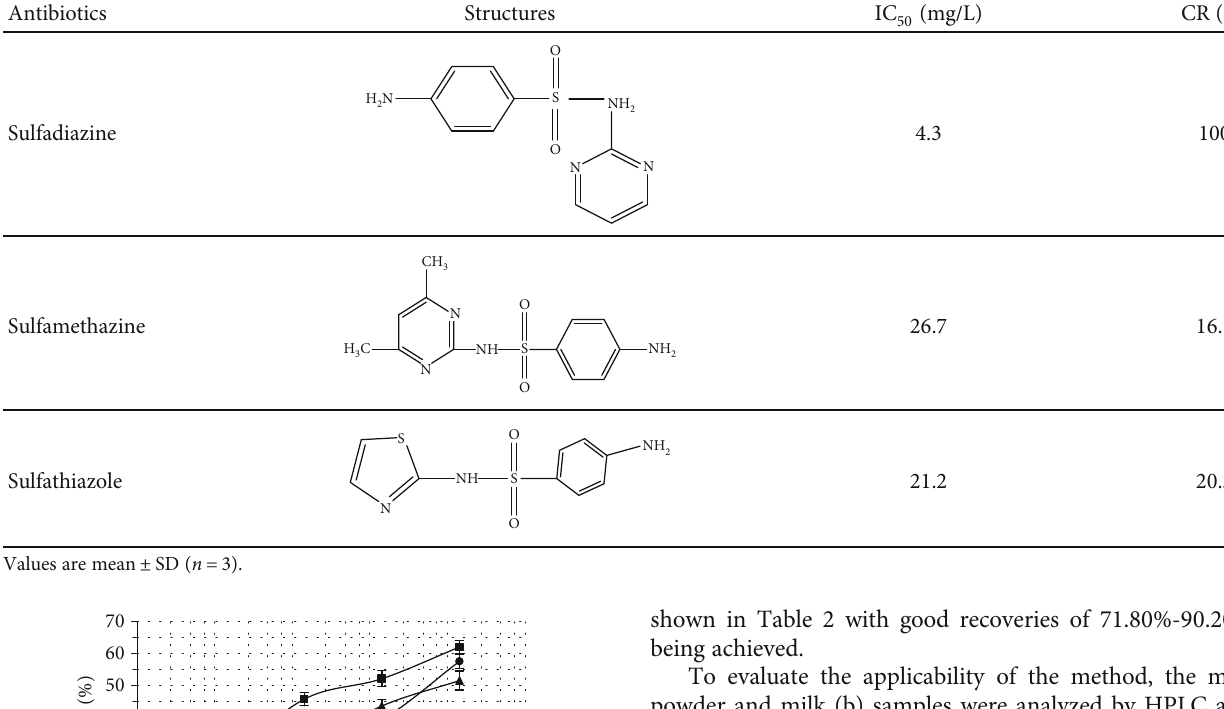
Table 1: The structure, sensitivity ( IC Antibiotics